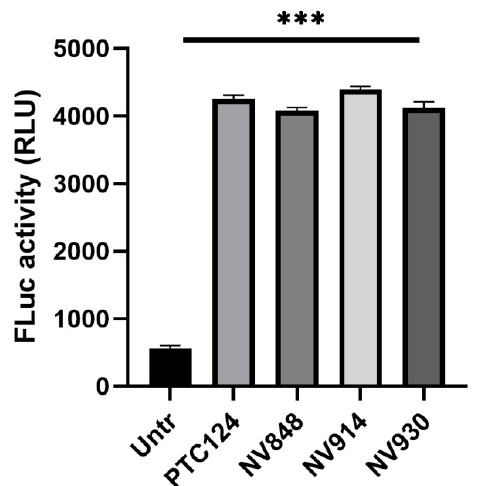
Figure 5. The newly synthesized molecules show readthrough activity in the FLuc cell model system. Histogram shows luciferase (FLuc) activity (RLU) after 24 h of exposition to PTC124, NV848 , NV930 , and NV914 (all at the concentration of 12 μ M) in HeLa FLuc-opal transfected cells. Data were analyzed by GraphPad Prism 6 software and expressed as mean values ± standard error of the mean (SEM; n = 3). Symbol (*) represents the statistical significance of data regarding PTC124, NV848 , NV914 , and NV930 versus Untr: ***, p < 0.001 (ANOVA with Dunnett’s posthoc test).